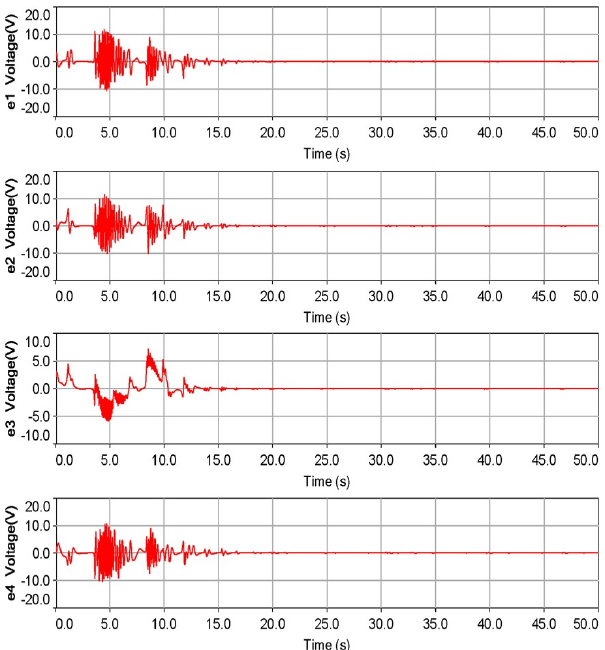
Figure 13. Time histories of the error states.